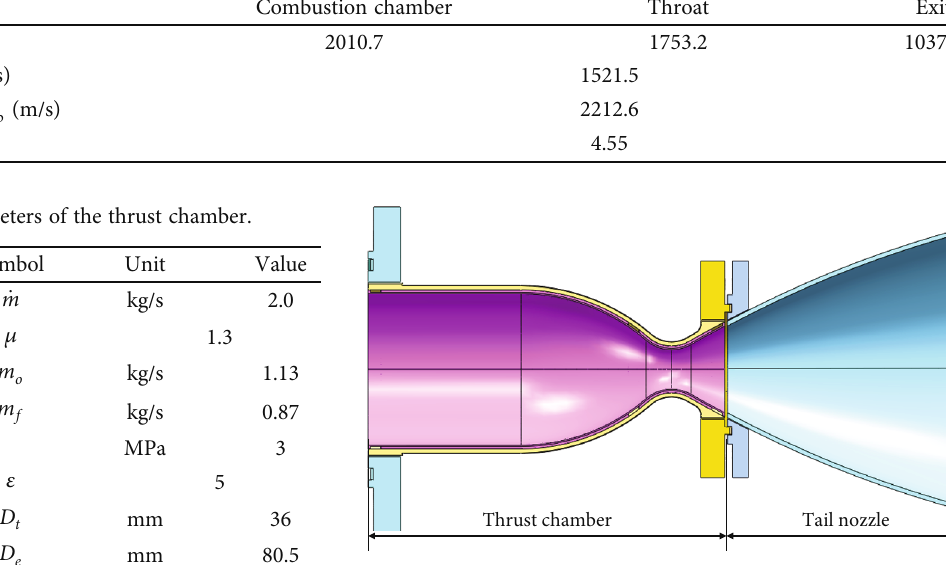
Figure 2: The structure schematic of the thrust chamber.